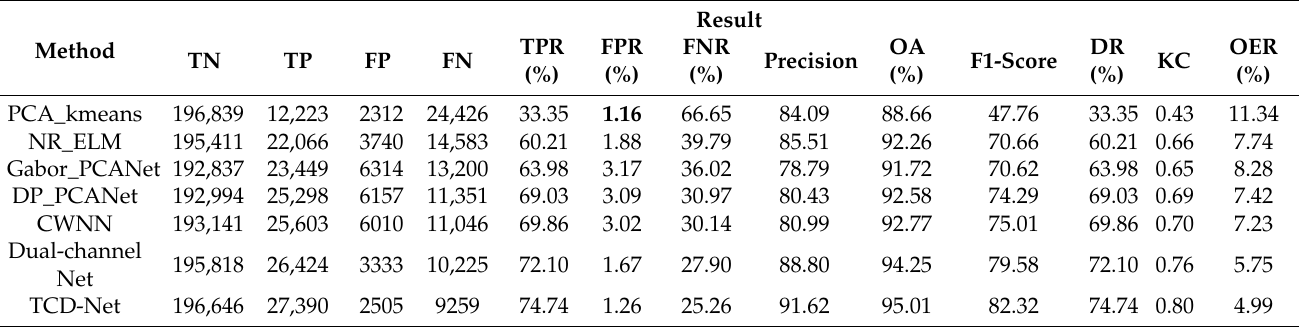
Table 6. The accuracy of different change detection methods for